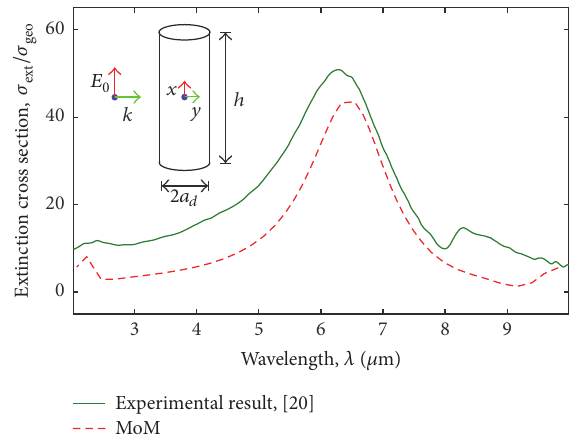
Figure 5: Extinction cross section normalized by the area of the /𝜎 ) as a function of wavelength 𝜆 . geometrical cross section (𝜎 ext geo The green solid line shows the results measured for a gold nanorod arrangement excited by a plane wave, which can be found in Figure 4 of [20]. The red dashed line shows the simulated result for a gold nanorod excited by a plane wave with ℎ = 400 nm, 𝑎 𝑑 = 47.5 nm, and 𝑁 𝑡 = 10. 𝜎 = 𝑃 /𝑆 = 𝑃 /𝑆 and 𝜎 , where 𝑃 and 𝑃 abs dis inc sca sca inc dis sca